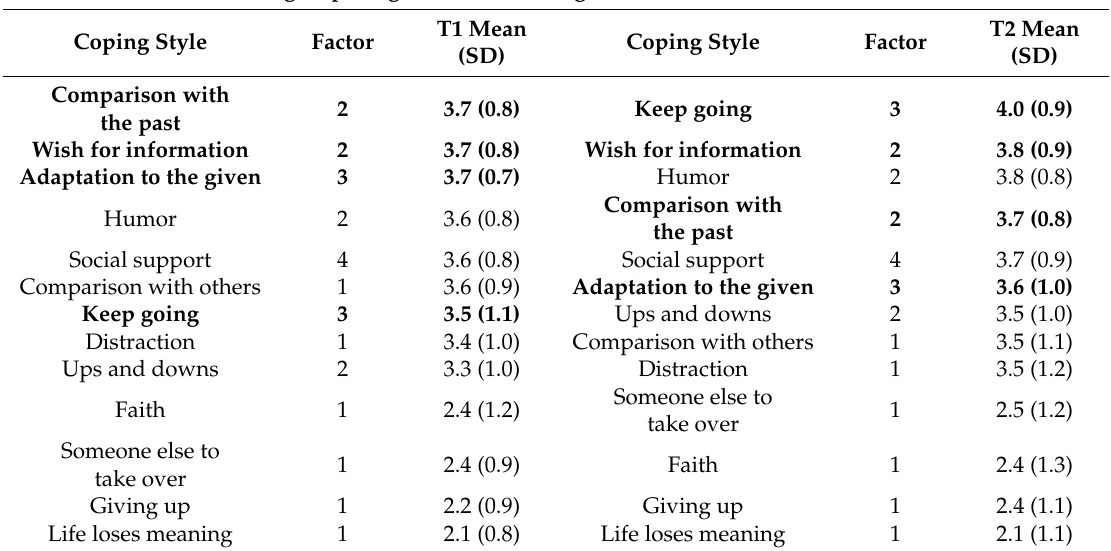
Table 7. Rating of coping styles over time, by Hoehn and Yahr (HY) subgroups; Factor solution revealed at baseline, in short: 1 = pessimistic, 2 = optimistic, 3 = persistent, 4 = support-seeking. HY Subgroup “High Stable”, i.e., High (HY 3–5) at T1 and T2 ( n =